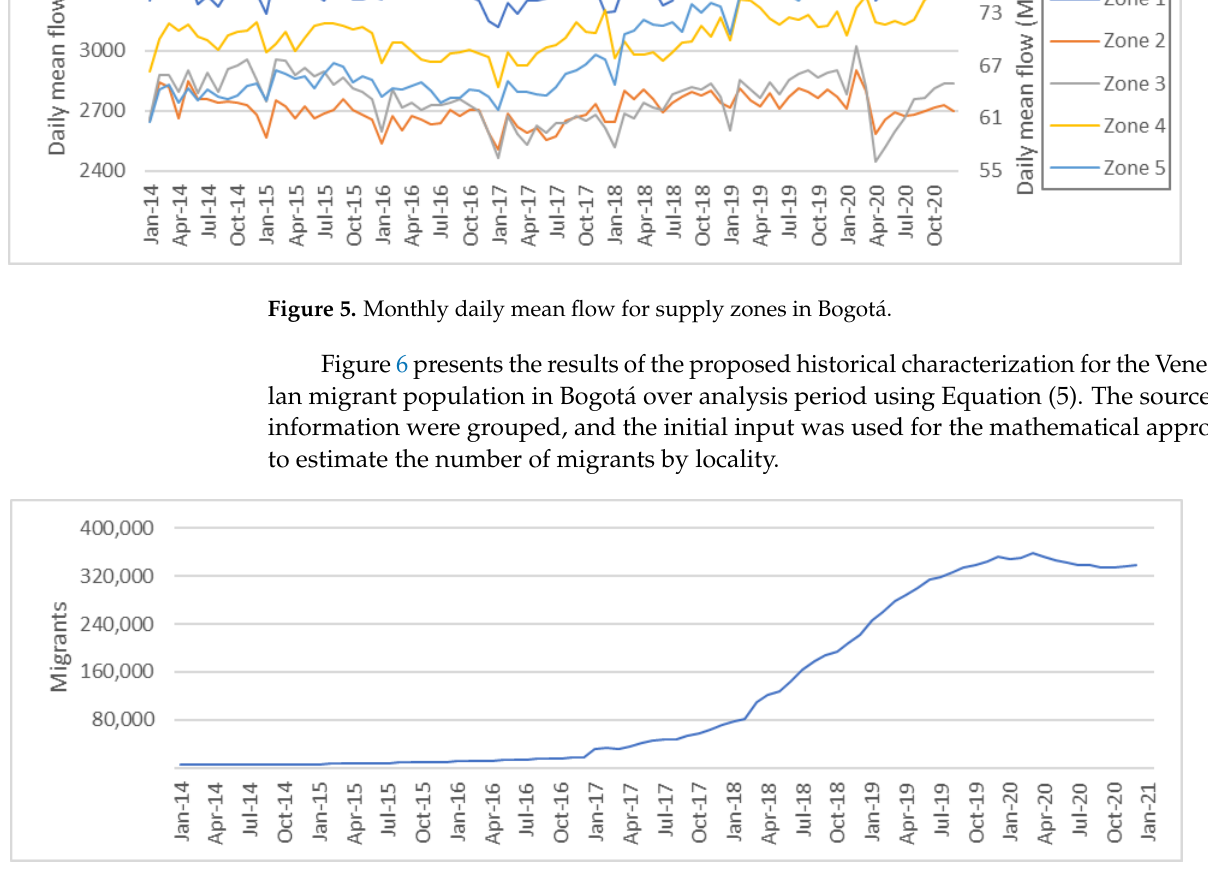
Figure 6. Characterization of migrant population in Bogotá.